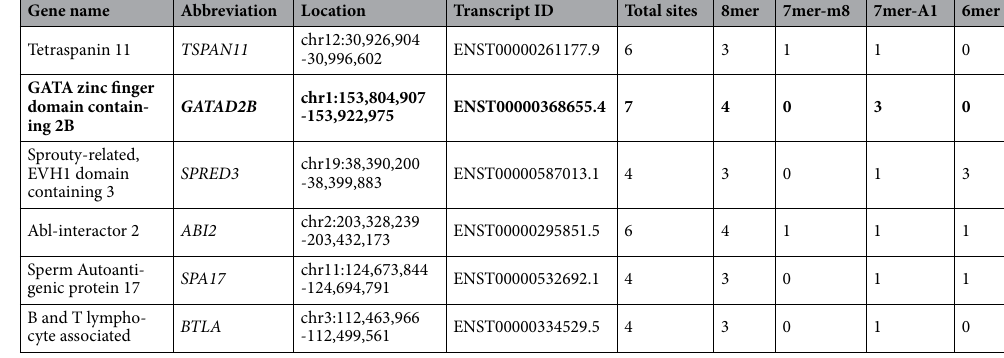
Table 1. Target gene candidate list of hsa-miRNA-625-5p. GATAD2B gene in bold was selected as hsa- miRNA-625-5p target gene. Each column of table shows the name of the target gene, abbreviation of the gene name, the location in the human chromosome, transcript ID, total hsa-miRNA-625-5p binding sites in 3 ′ UTR, total binding sites for 8mer, total binding sites for 7mer-m8, total binding sites for 7mer-A1 and total binding sites for